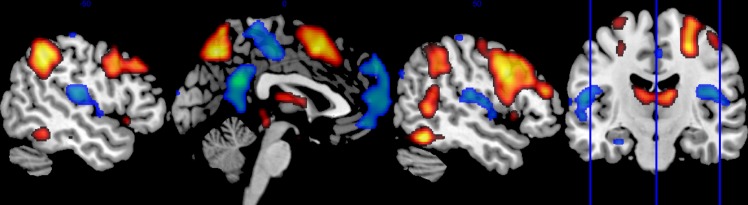
Positive and negative BOLD responses during executive processing.The sagittal brain images show whole brain group activation during the working memory task. Areas in orange/red denote positive BOLD responses, which were mainly found in the executive network. Areas in green/blue denote negative BOLD responses, which were mainly found in the default mode network. The coronal image shows the position of visualized sagittal slices.